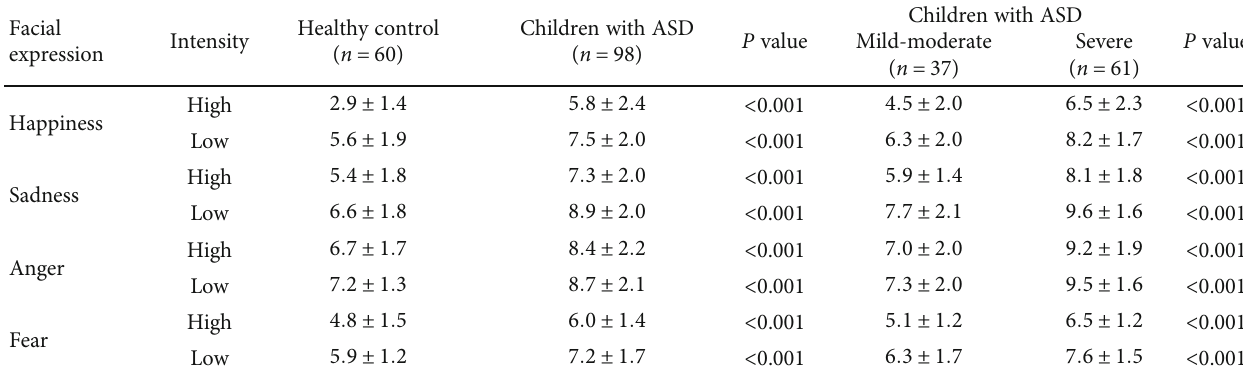
Table 1: Comparison of the response time (seconds) for recognition of facial emotions between groups.